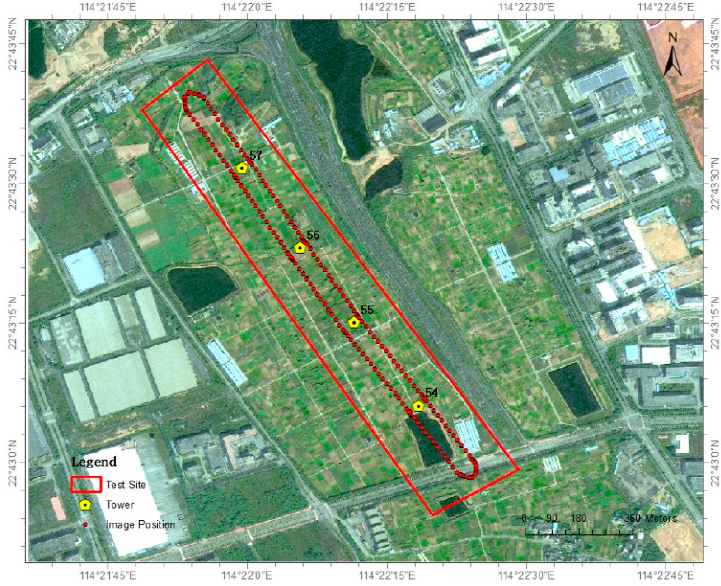
Figure 4. Location of test site. The red polygon indicates region of test site. Image positions calculated by differential GNSS are rendered by red circles. Yellow pentagons stand for pylons.